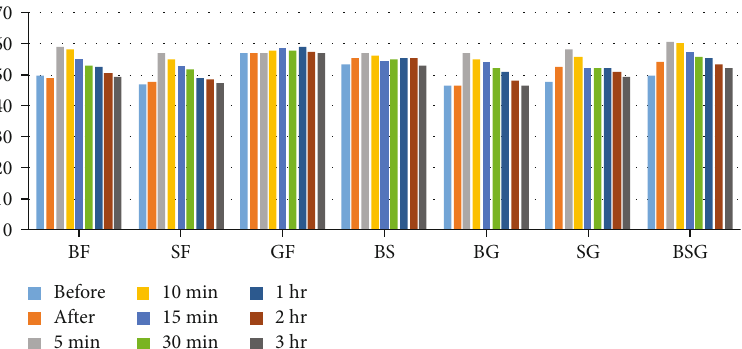
Figure 1: Mean RR at di ff erent time points for all the feeding